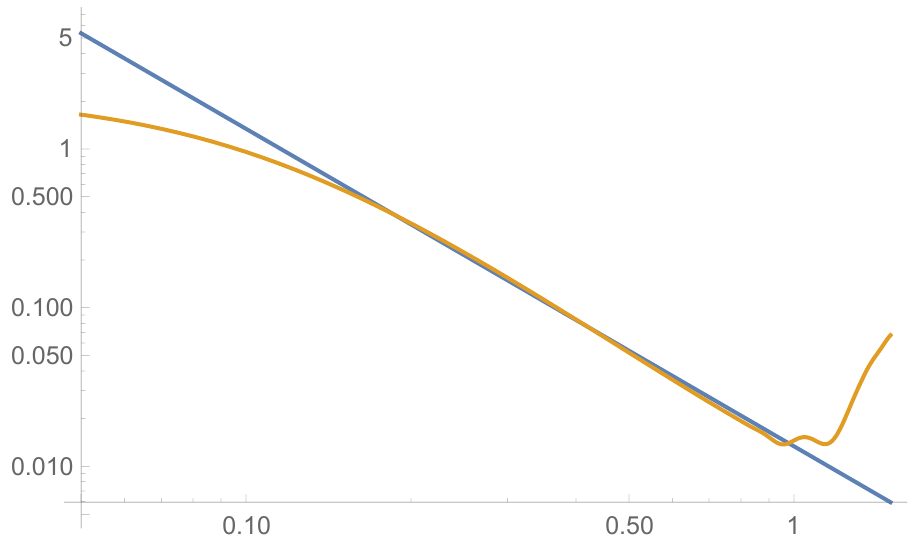
Figure 11 . Behaviour of the dip in the log-log plot of the SFF for the (cid:12)rst 20000 zeroes (yellow line) plotted against the curve y / 1 . The agreement is very good, as t 2